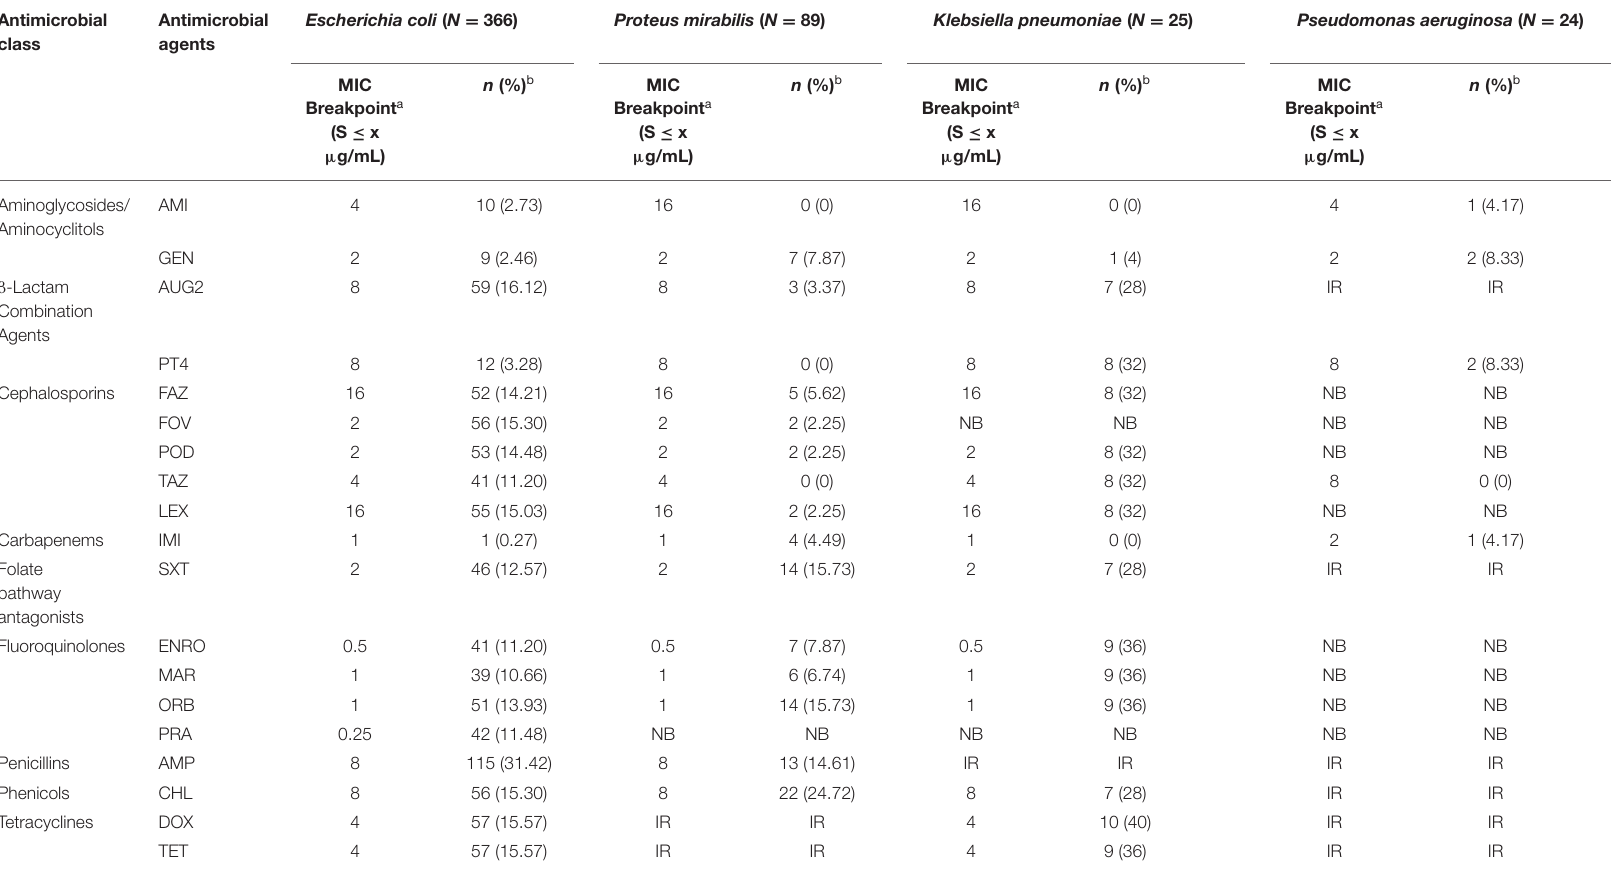
TABLE 4 | The proportion of antimicrobial resistance in Gram-negative bacteria isolated from urine samples submitted to the Veterinary Diagnostic Laboratory, University of Illinois College of Veterinary Medicine, 2019–2020. Antimicrobial